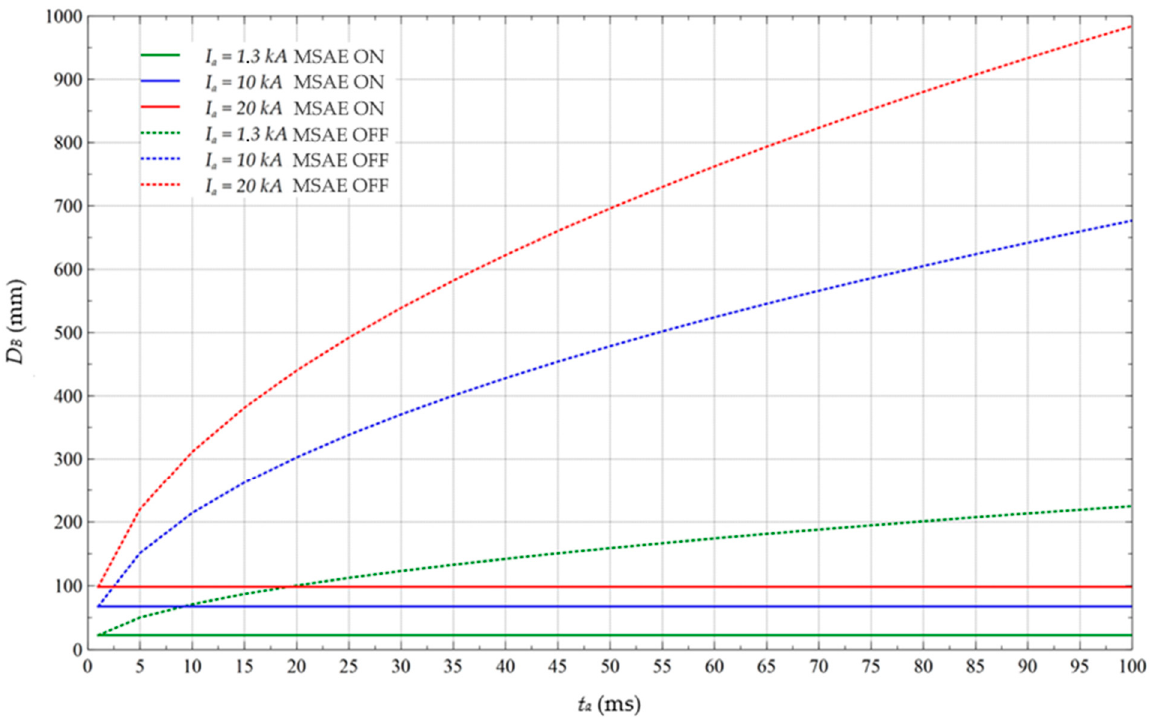
Figure 15. Characteristics of the arc flash boundary as a function of the duration of the arc disturbance for different values of the current in the circuit with the MSAE system and its absence.